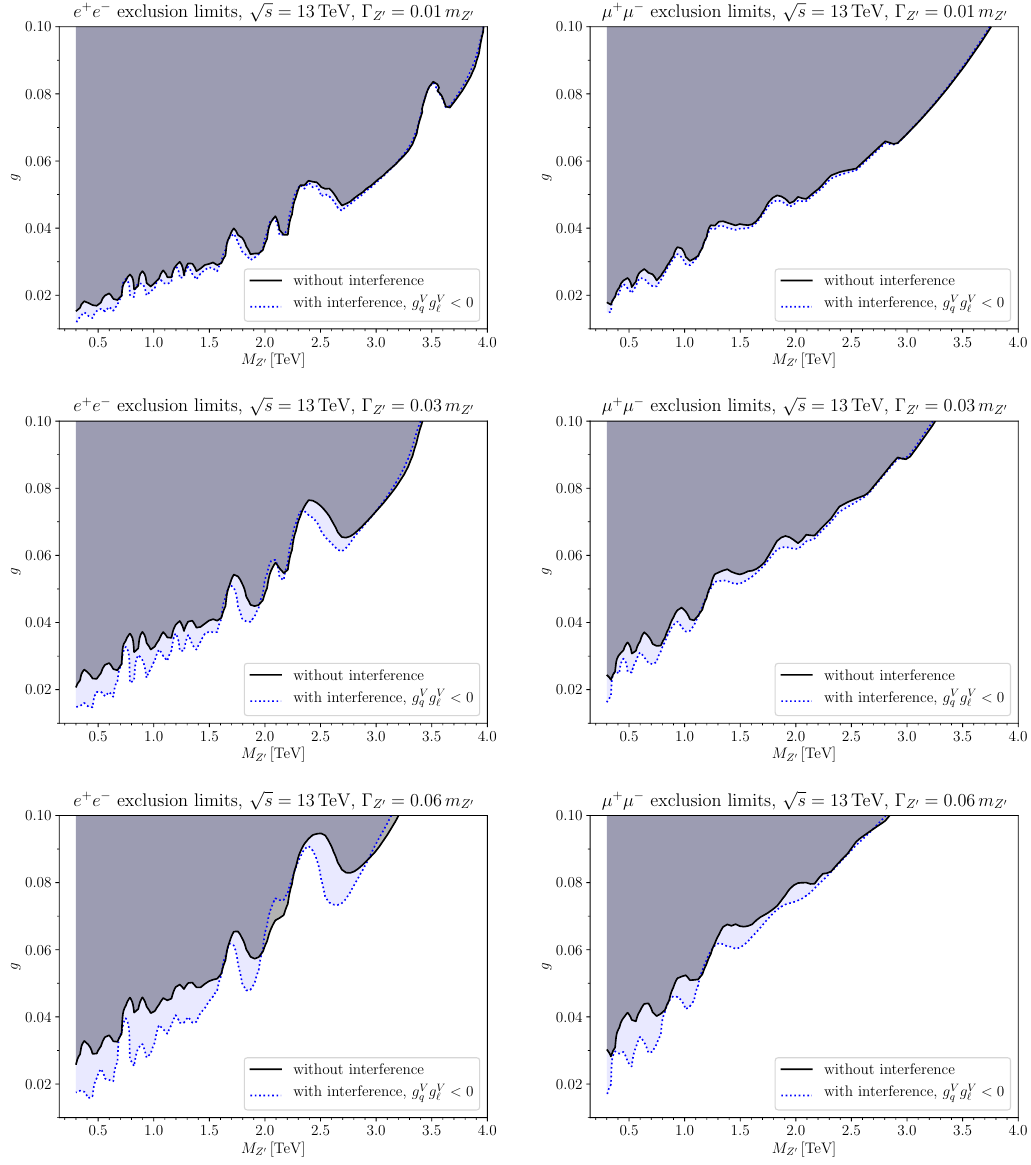
Figure 9 . Same as (cid:12)gure 6 but for the case that g V